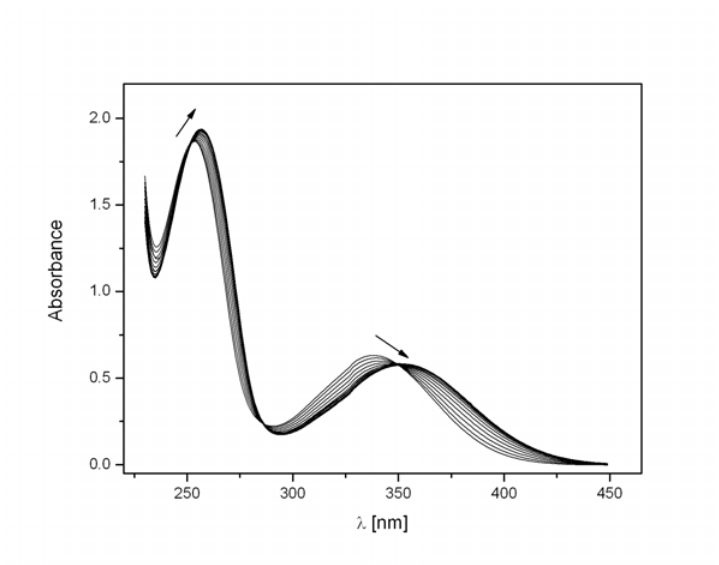
Fig. 2 Absorption spectra recorded in acetonitrile solution containing A18C6-Dns (1.5 × 10 − 4 mol dm − 3 ) and calcium perchlorate (0-1.27 × 10 − 3 mol dm − 3